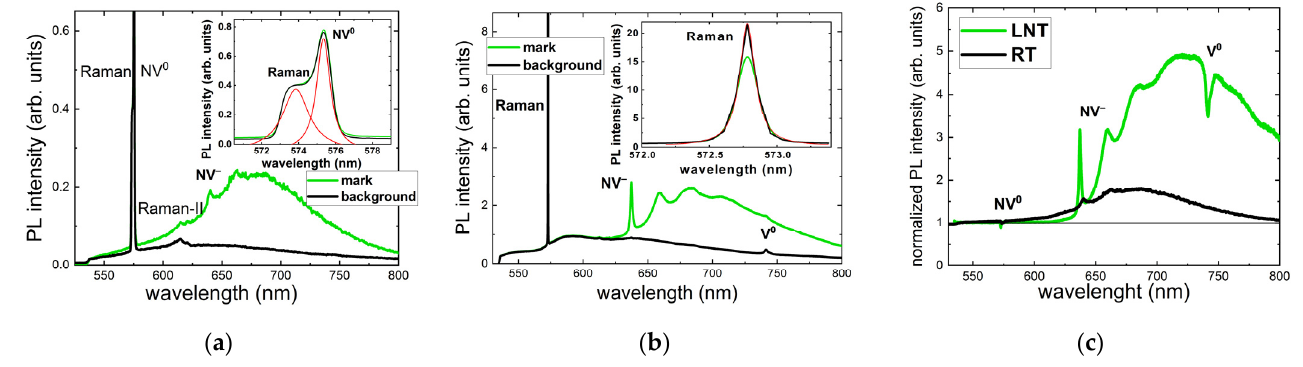
Figure 4. RT ( a ) and LNT ( b ) 532 nm PL spectra of the background, micromarks, and their normalized intensity ( c ) for an exposure time of 240 s (24 M pulses) and an incident 0.3 ps laser pulse energy of 1.6 μ J. Spectral assignment after [5].